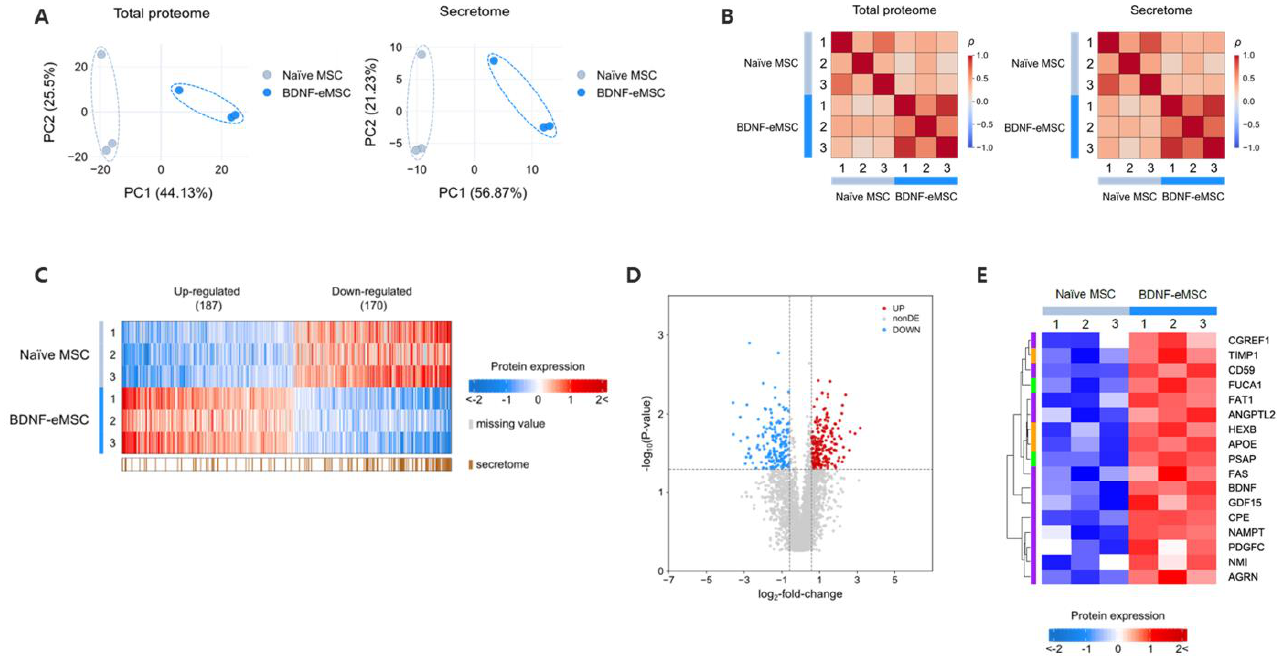
Figure 2. Proteomic analysis of BDNF-eMSC supernatant. ( A ) The principal component analysis (PCA) shows the first two principal components of data regarding their relationship in total proteome or secretome. ( B ) Correlation analysis shows replicates of the same pipeline cluster at both total proteome and secretome levels. ( C ) Heatmap of differentially expressed proteins (DEPs) in the total proteome (red and blue) and secretome (brown). ( D ) Volcano plot analysis shows DEPs of the total proteome. Red dots indicate significantly up-regulated genes, and blue dots indicate down-regulated genes. ( E ) Heatmap of significantly up-regulated proteins in secretome of BDNF-eMSCs compared to naïve MSCs. Analyzed DEPs are selected by BDNF-eMSCs enriched gene ontology biological process (GOBP) analysis: neurogenesis (purple), metabolism (green), or both